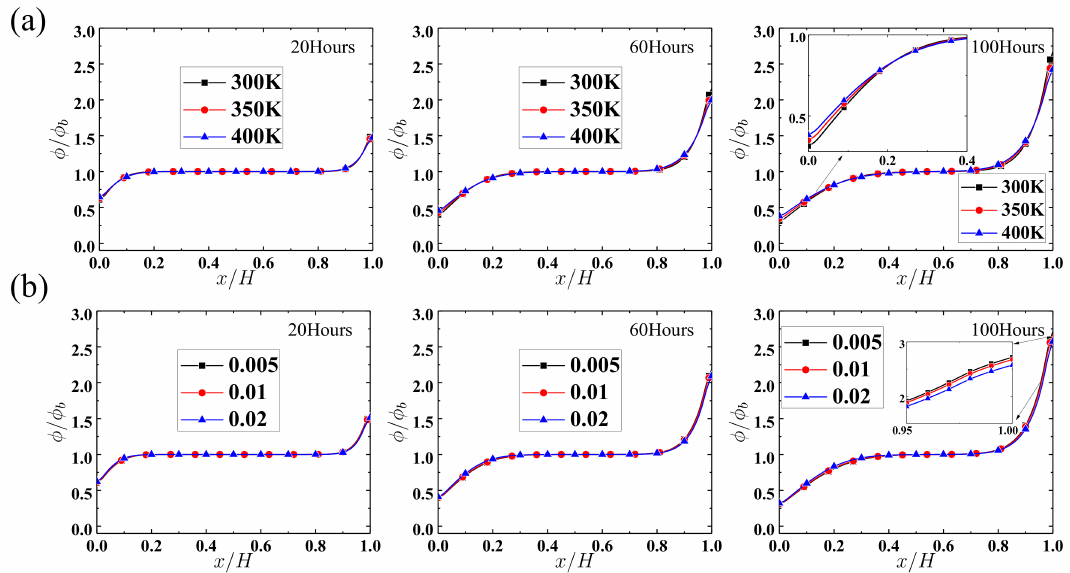
Figure 6. Effects of ( a ) the ground temperature and ( b ) the bulk nanoparticle concentration on the nanoparticle concentration profile along the X-direction at radial position R = 1.167 for different